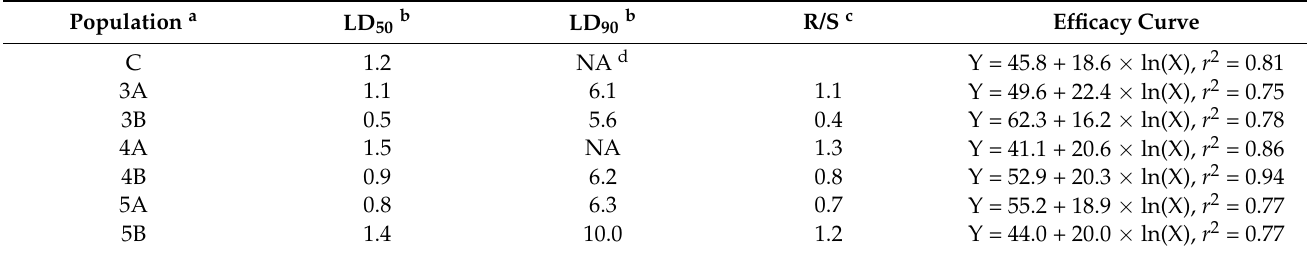
Table 2. Waterhemp population control with acetochlor under germination chamber conditions.